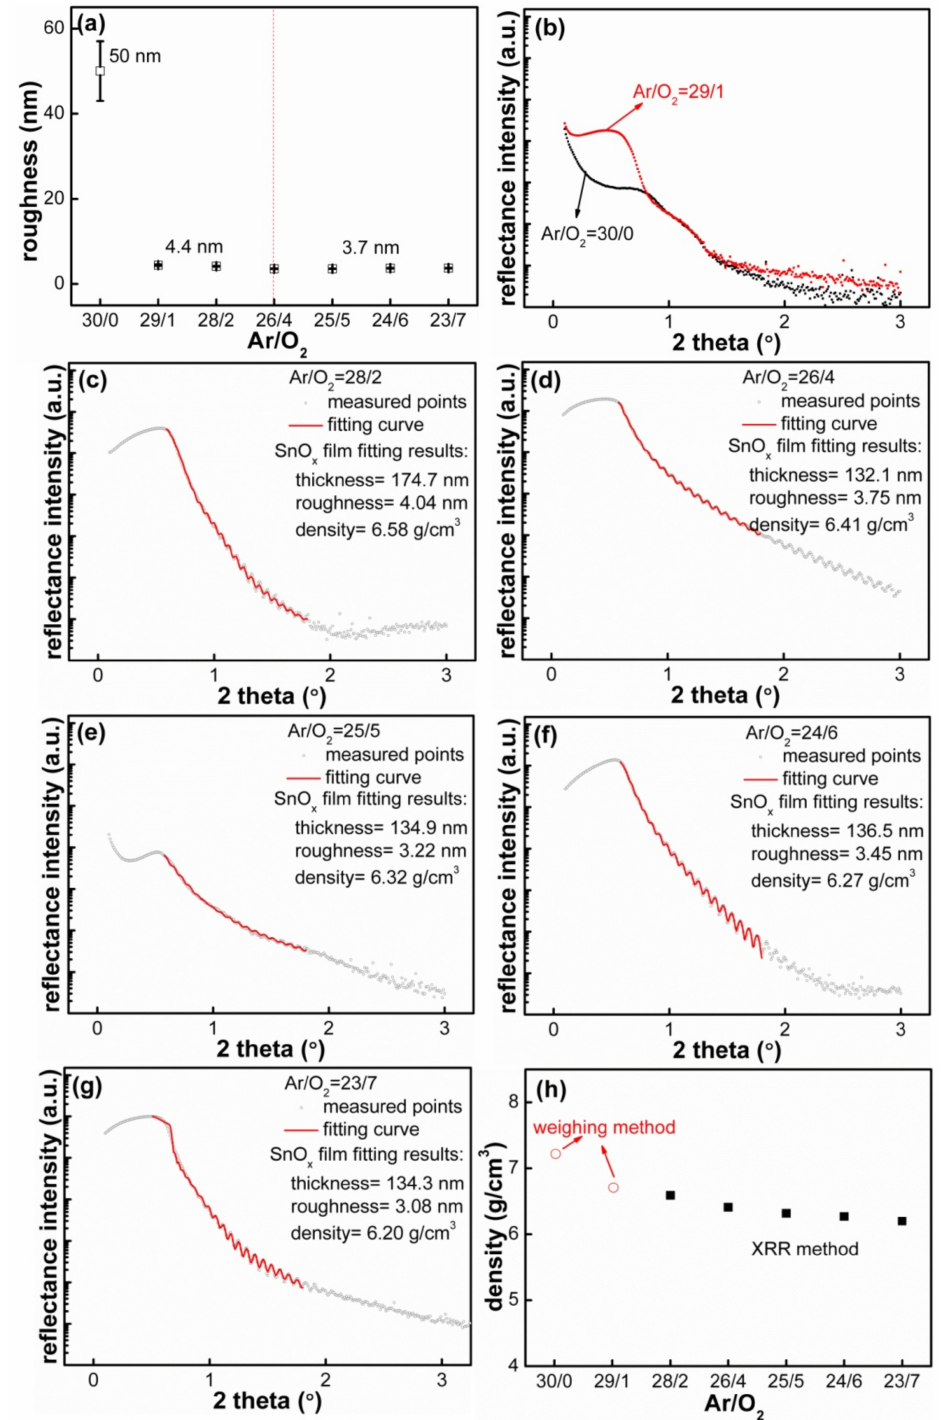
Figure 3. ( a ) Summary of the surface roughness measured by AFM; ( b ) the reflectance curves of the films deposited with Ar/O 2 = 30/0 and 29/1; the reflectance curves and fitting results of the films deposited with ( c ) Ar/O 2 = 28/2, ( d ) Ar/O 2 = 26/4, ( e ) Ar/O 2 = 25/5, ( f ) Ar/O 2 = 24/6 and ( g ) Ar/O 2 = 23/7; ( h ) the film density as a function of Ar/O 2 flow